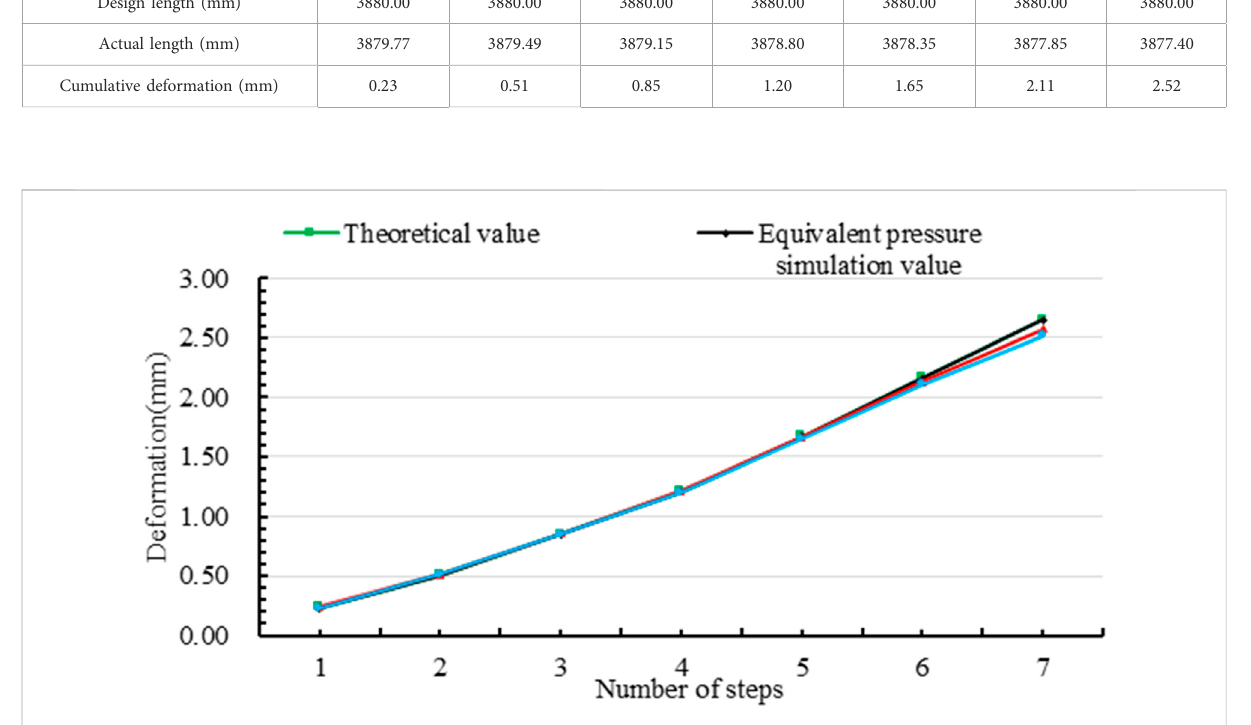
FIGURE 11 Comparison of cumulative deformation of